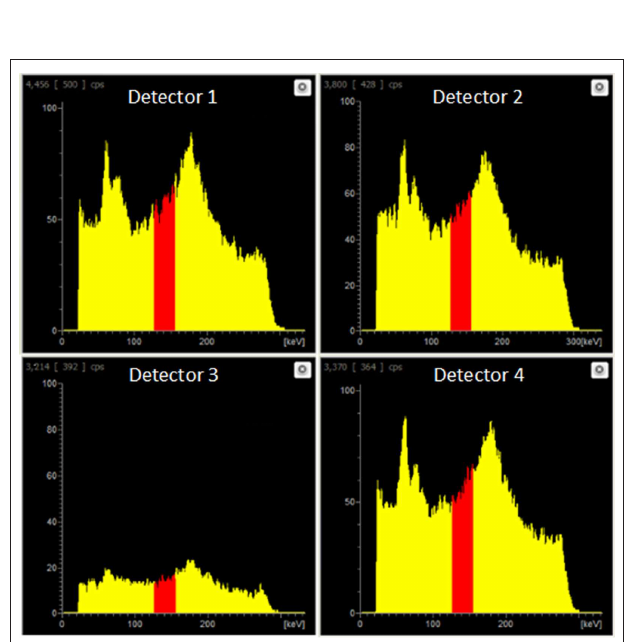
FIGURE 7 | Live acquisition energy spectrum obtained during a SPECT scan of an 18 F-only phantom (1 MBq). A range of energies is evident, including energies in the 140.5 keV ± 10% (i.e. 20% width) 99m Tc energy window